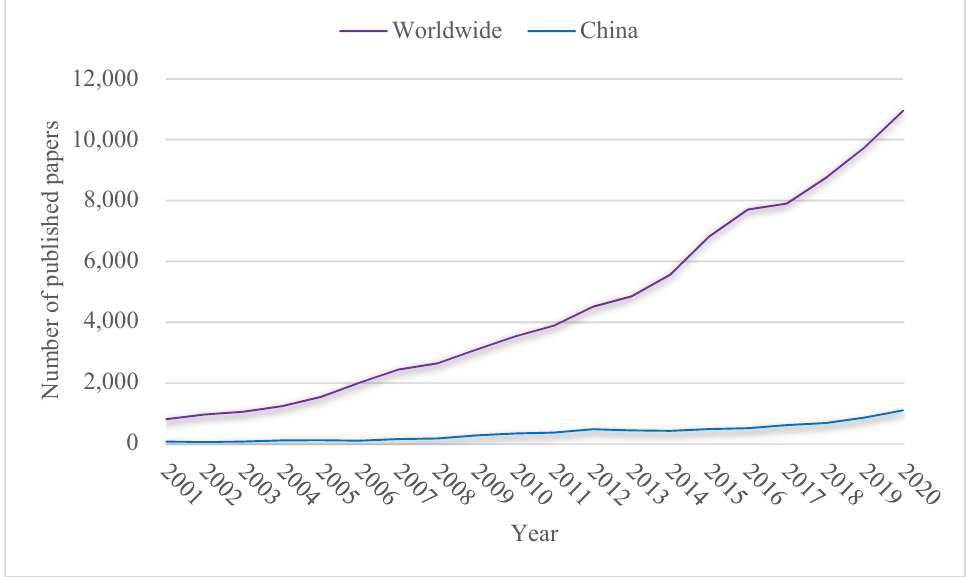
Figure 1. The number of disaster studies in China and the worldwide from 2001 to 2020 (Data source: Web of Science, Access date: 14 October 2021).